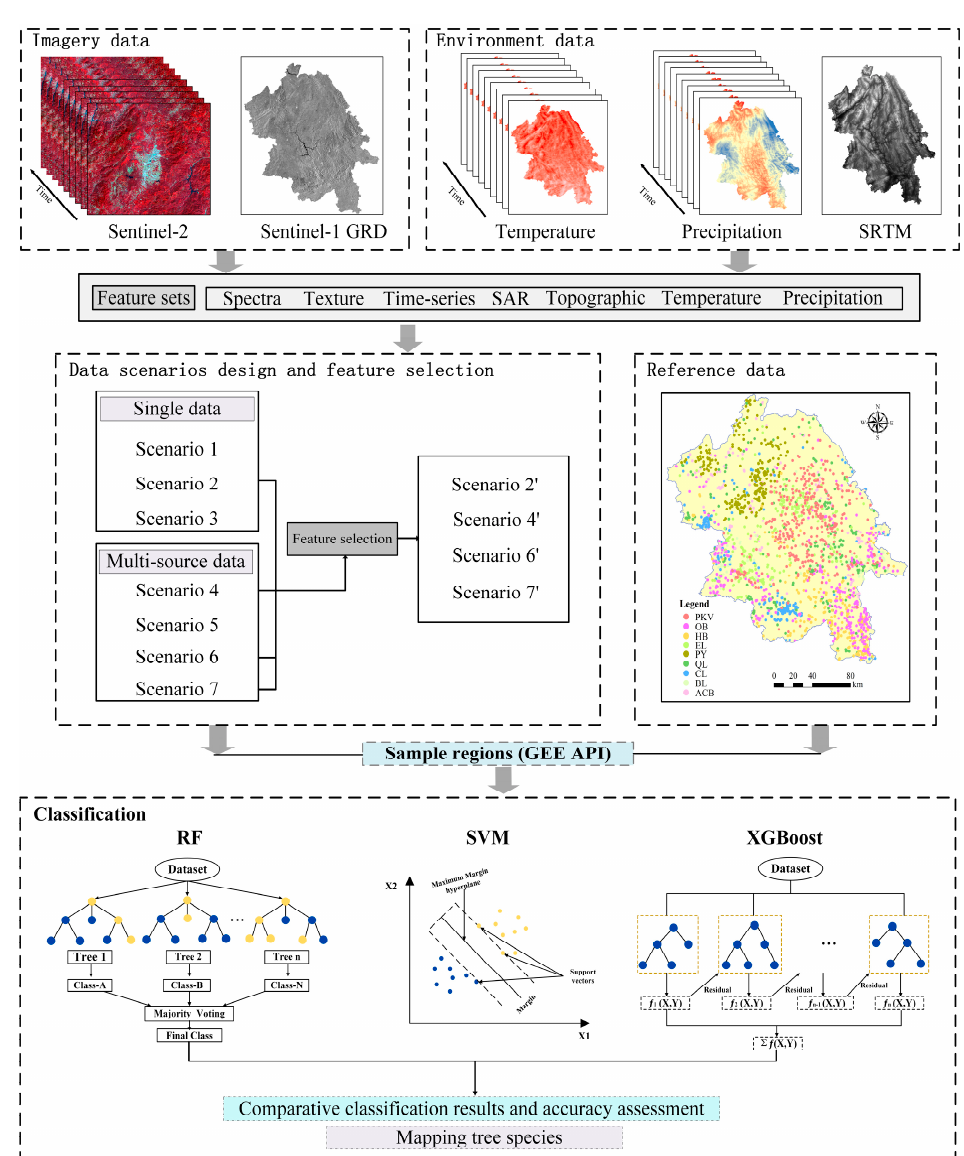
Figure 3. Flowchart of the proposed method.